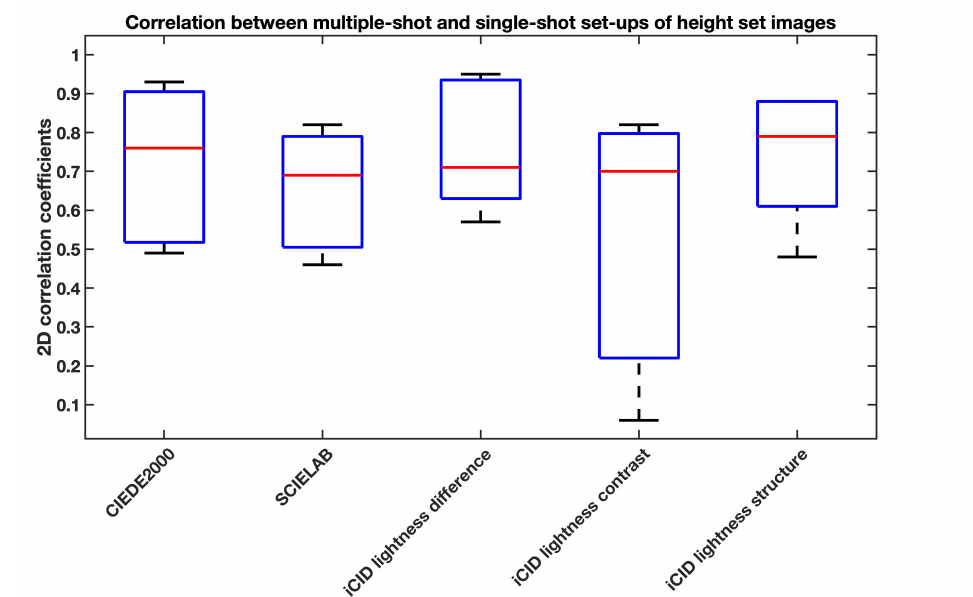
Figure 13. The boxplot of correlation between two set-ups of height set images by the tested IQMs. iCID’s lightness contrast map has a very spread range among the